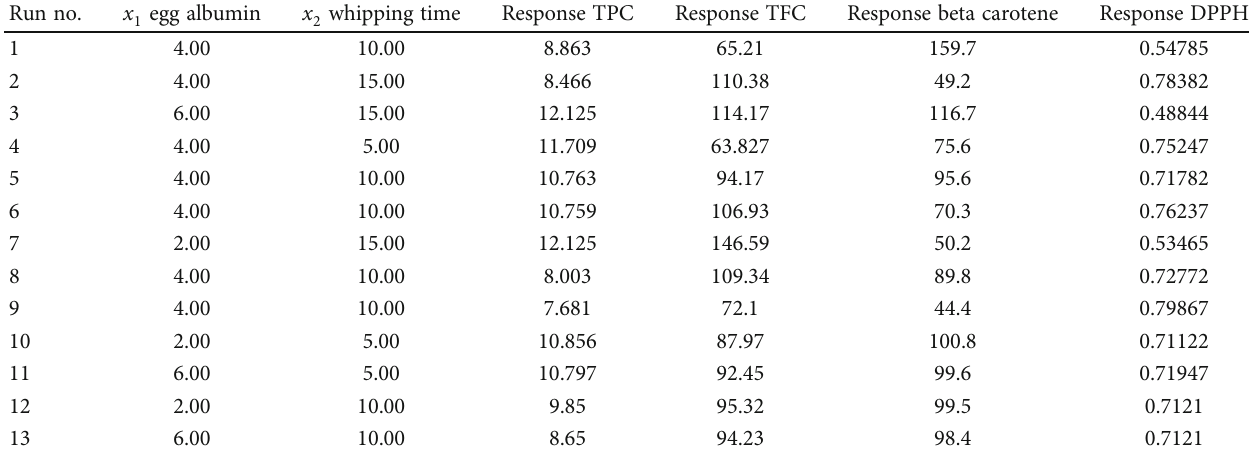
Table 5: Central composite face center design corresponding responses, TPC (GAE/g), TFC (mg/100 g), beta carotene ( μ g/100g), and DPPH (%) with x = egg albumin (%) and x = whipping time (min). 1 2 Run no.